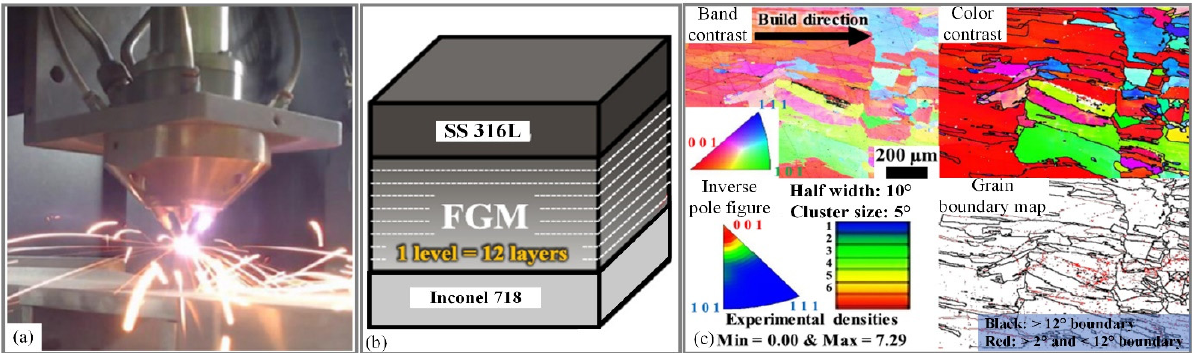
Figure 4. ( a ) Photographic image of the LENS TM process, ( b ) Schematic of the FGMs Inconel 718/SS 316L, ( c ) EBSD micrographs of the FGM in the defective compositional range of 30 wt% Inconel 718/70 wt% SS 316L to 20 wt% Inconel 718/80 wt% SS 316L [50].